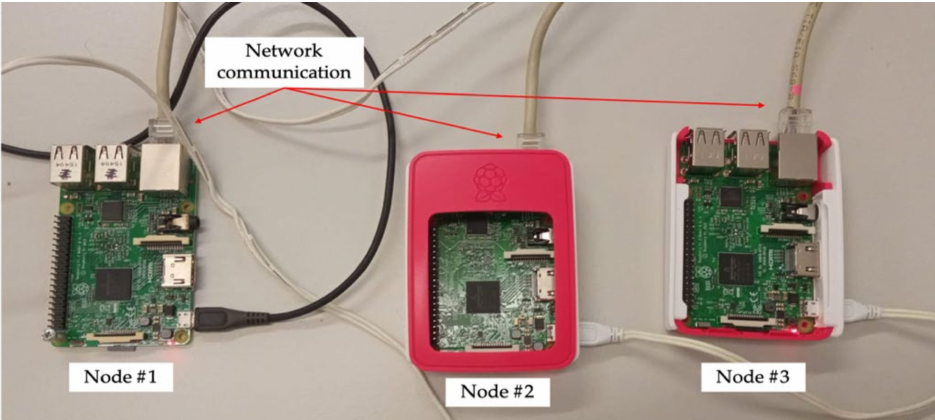
Figure 4. The IoT hardware setup. In the figure, 3 RPi devices used for the simulation are shown. In this setup, RPis are physically connected through an Ethernet port, but Wi-Fi connection is